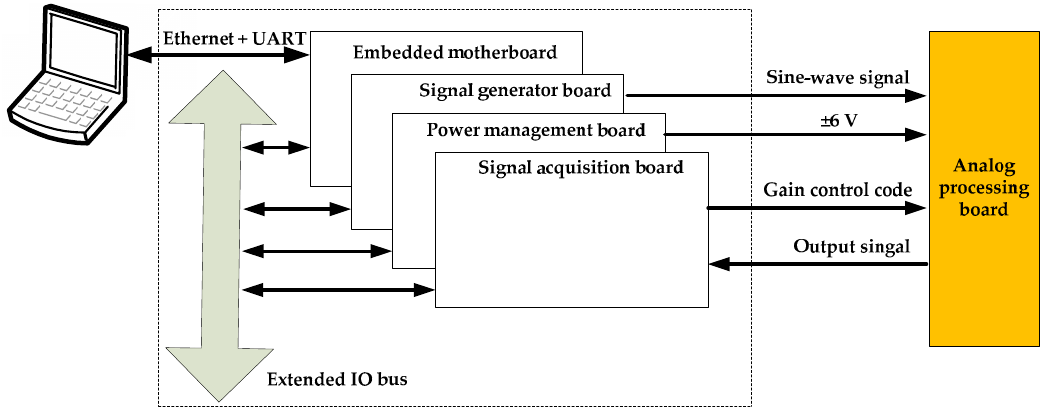
Figure 7. Diagnosis interface for the analog processing board.